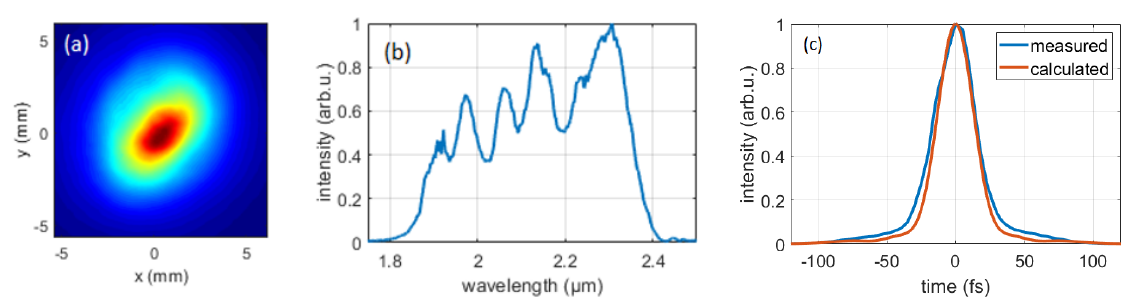
Fig. 1 Characterization of our power OPCPA system: (a) Near field spatial beam profile, (b) measured spectrum (FWHM = 430 nm) and (c) autocorrelation function, where the measured curve is shown in blue (FWHM = 34 fs) and the one calculated from the measured spectrum is shown in orange. The inferred pulse duration is 25